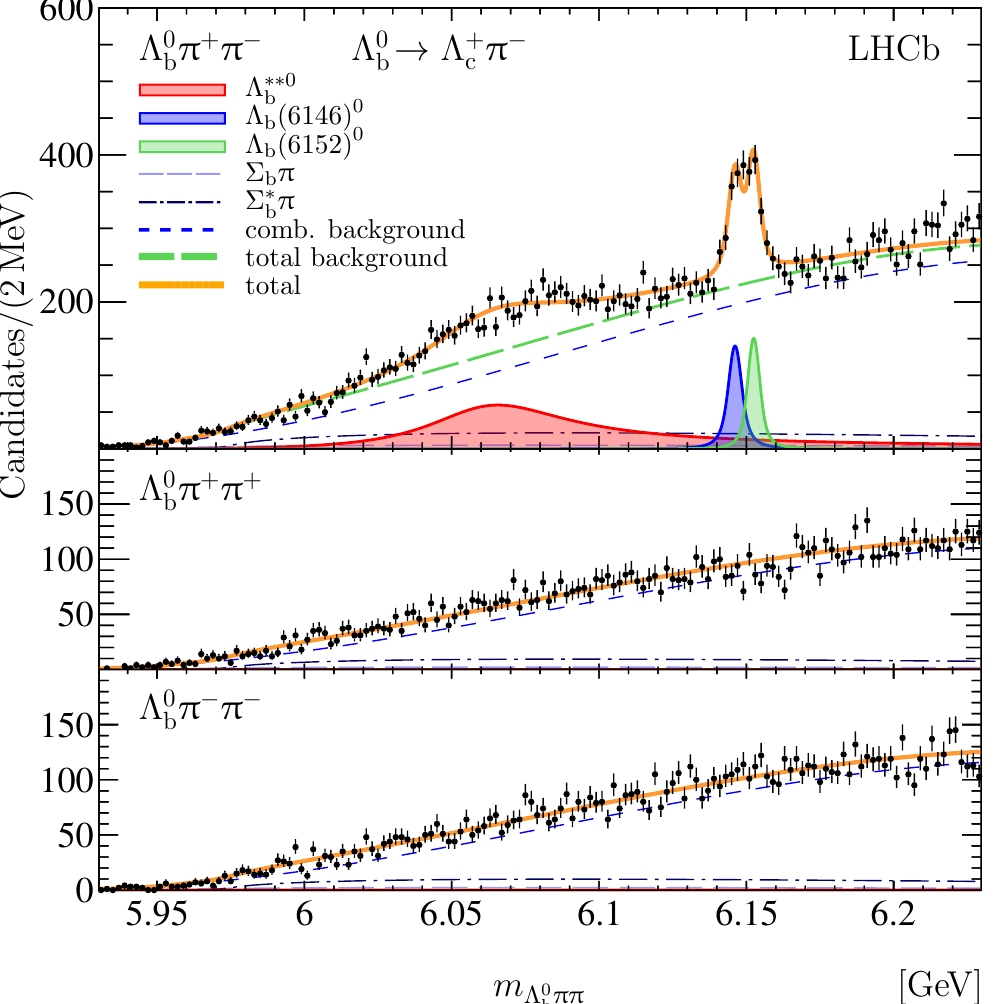
Figure 2 . Mass spectra of selected (top) (cid:3) 0 binations for the (cid:3) 0